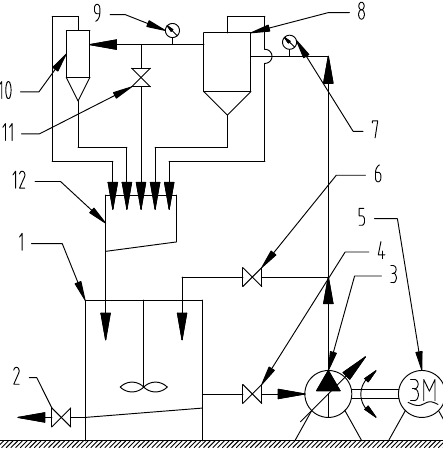
Figure 3. Schematic of the experimental apparatus. 1—Agitator; 2, 4, 6, 11—Valves; 3—Slurry pump;